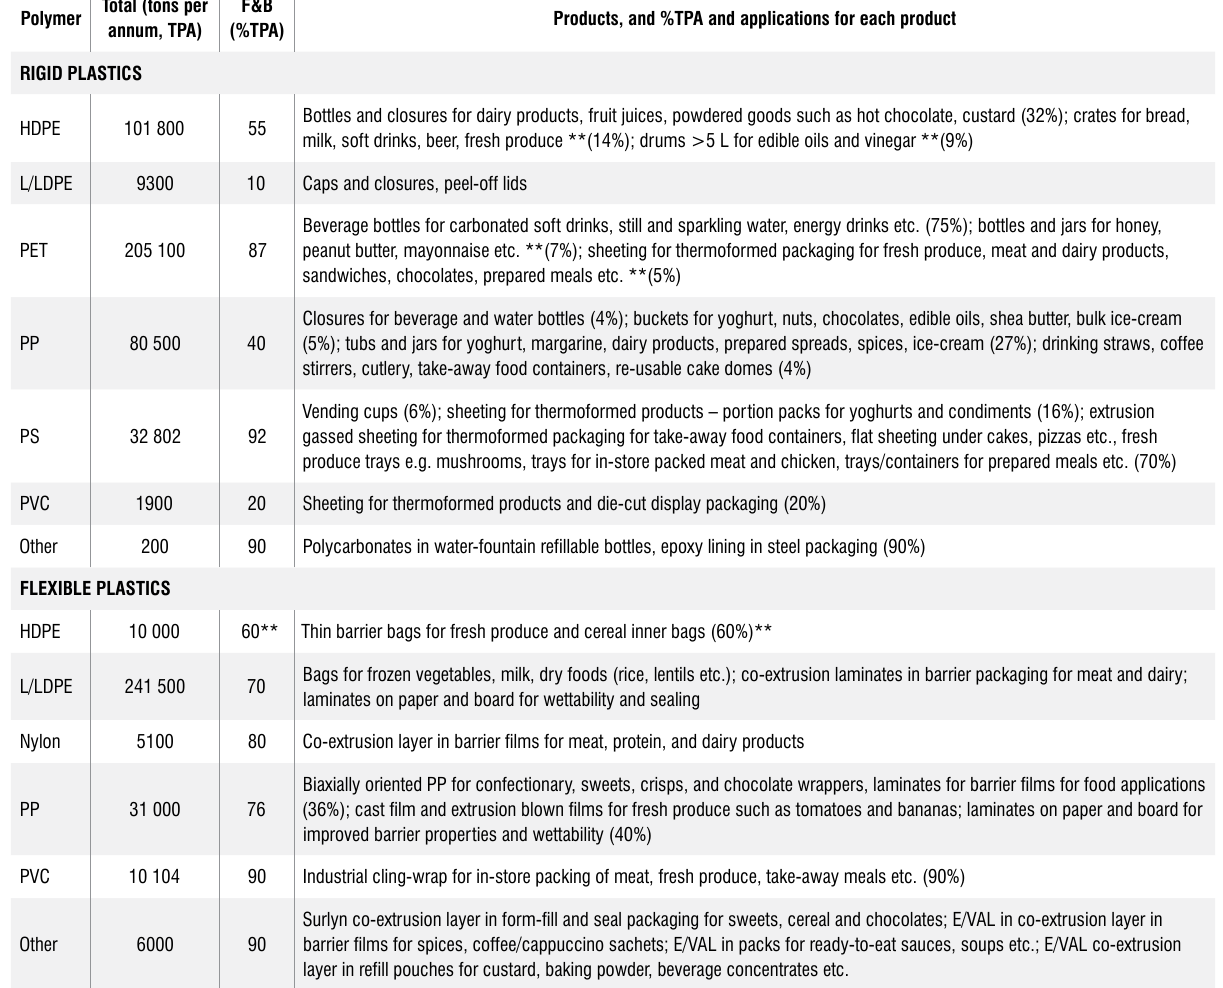
Products, and %TPA and applications for each